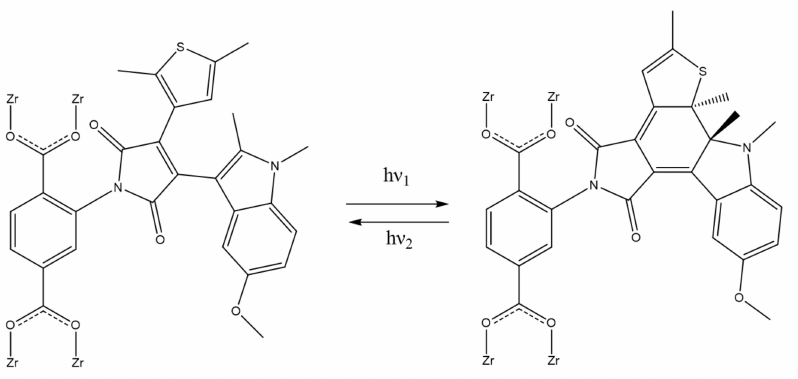
Figure 8. Scheme of DAE transformations inside DAE-UiO-66 pores under UV-light (h ν 1 ) and visible light (h ν 2